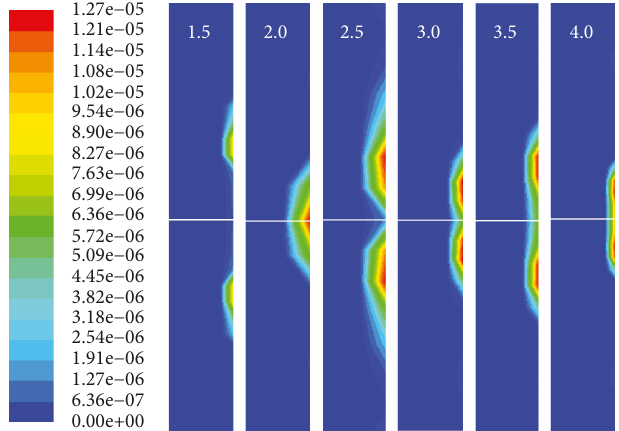
Figure 7: Erosion rates of rock at di ff erent contraction ratios. Table 4: Laval nozzle structure with di ff erent divergent angles. Nozzle parameters